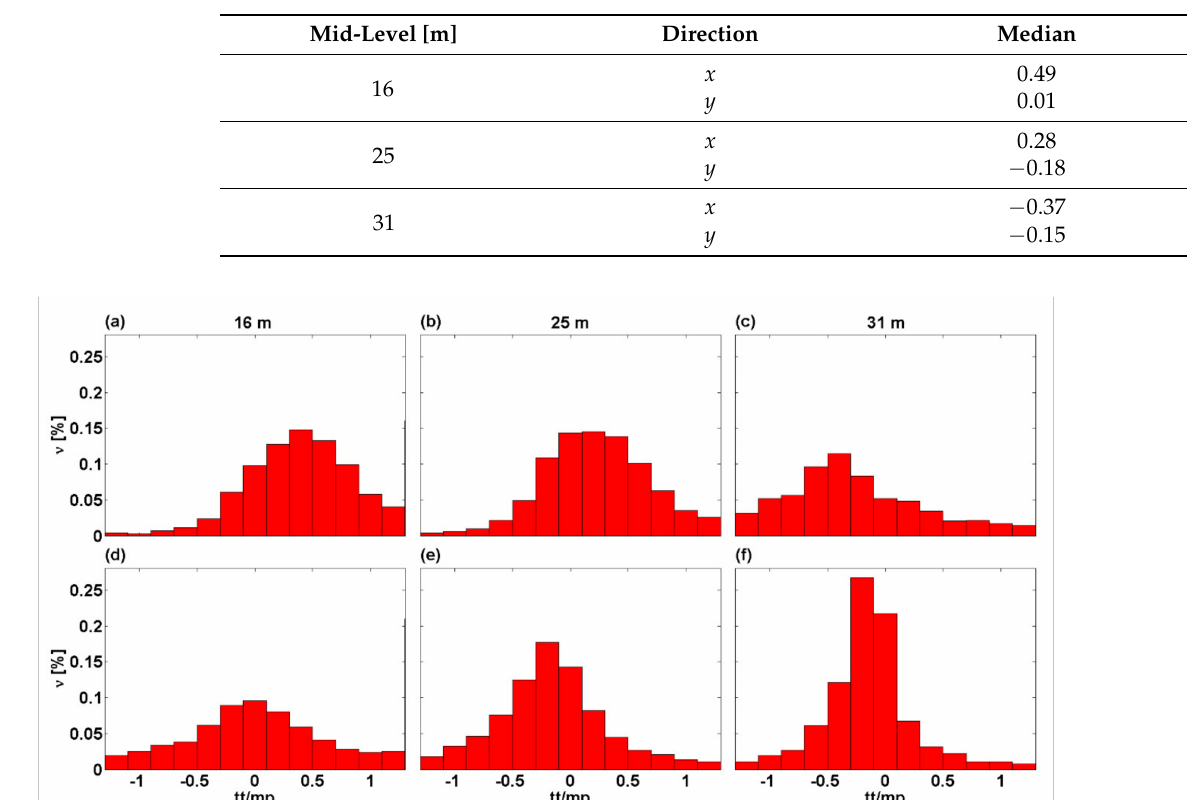
Figure 7. Histograms of the ratios between turbulence transport and mechanical production terms obtained for: ( a , d ) 16 m, ( b , e ) 25 m and ( c , f ) 31 m mid − levels. For every mid − level, the upper histograms, ( a – c ), refer to the longitudinal, and the lower histograms, ( d – f ), to the transversal direction. Medians are given in Table